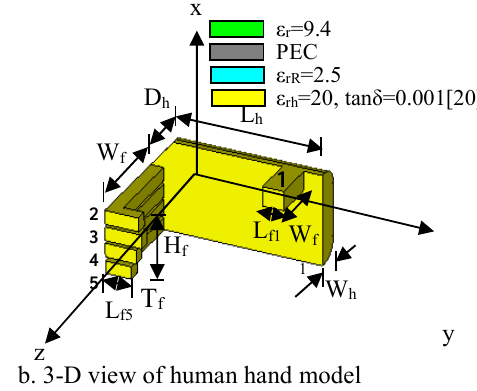
Fig.5. The geometry of circularly polarized DRA element mounted on a cylindrical ground plane placed inside a reader device in the presence of human hand model. Fig.3. The axial ratio and gain of the circularly Table 1. the detailed dimensions of the handheld reader device and human hand model (units: mm)